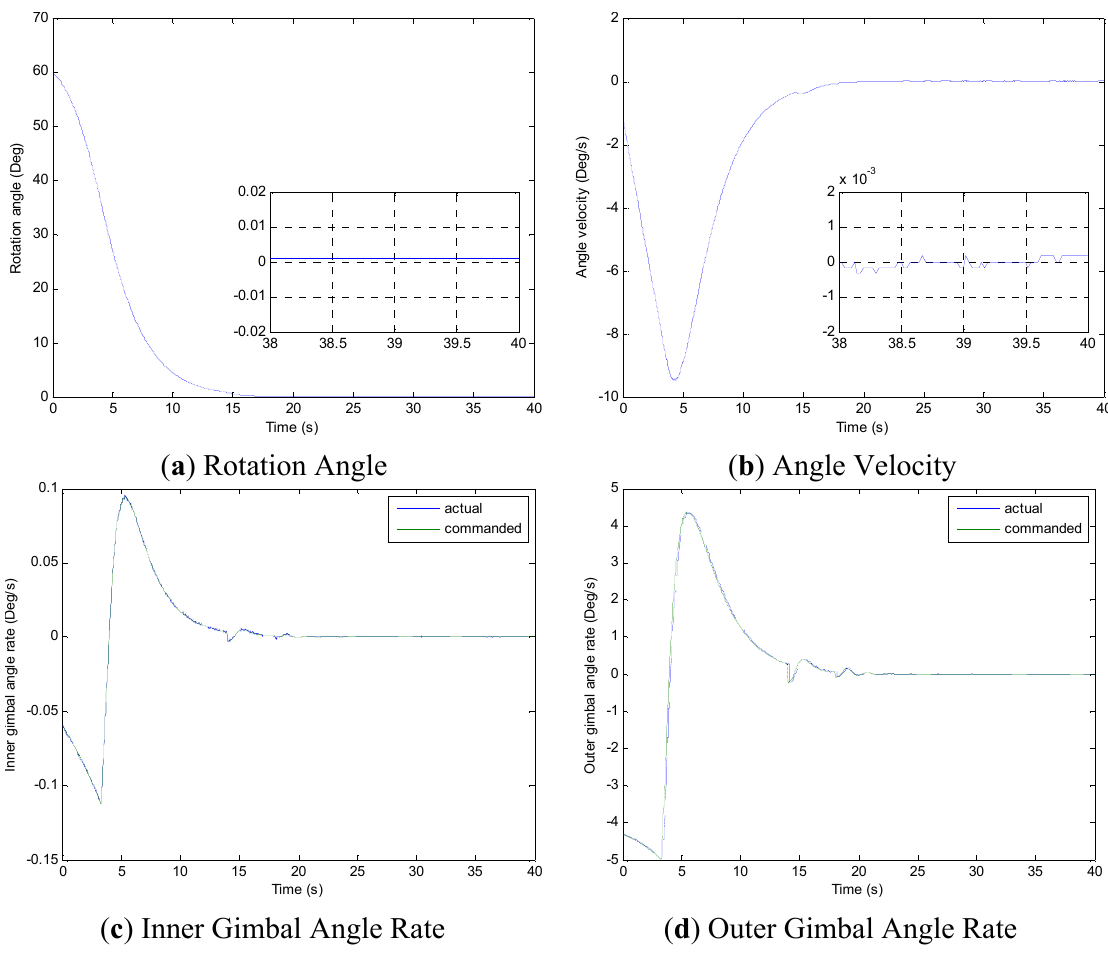
Figure 6. MSDGCMG Rotor Speed 20,000 rpm (Case